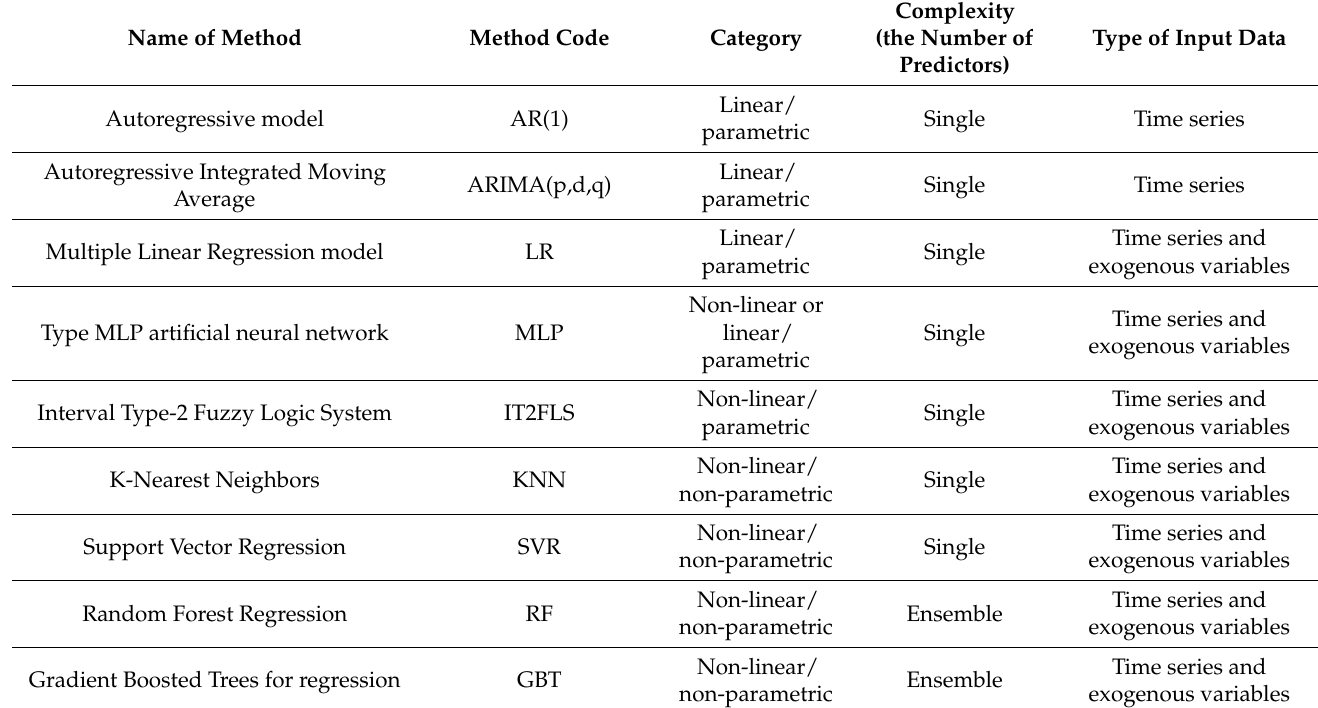
Figure 11. The general structure of four machine learning methods as an integrator of ensemble. Summary description of fifteen tested forecasting methods is shown in Table 5. There are two methods based on time series and thirteen methods based on time series and exogenous input data. The eight methods are ensemble methods, and the seven ones are single methods. Ten methods all are machine learning methods. Table 5. Summary description of fifteen tested forecasting methods.